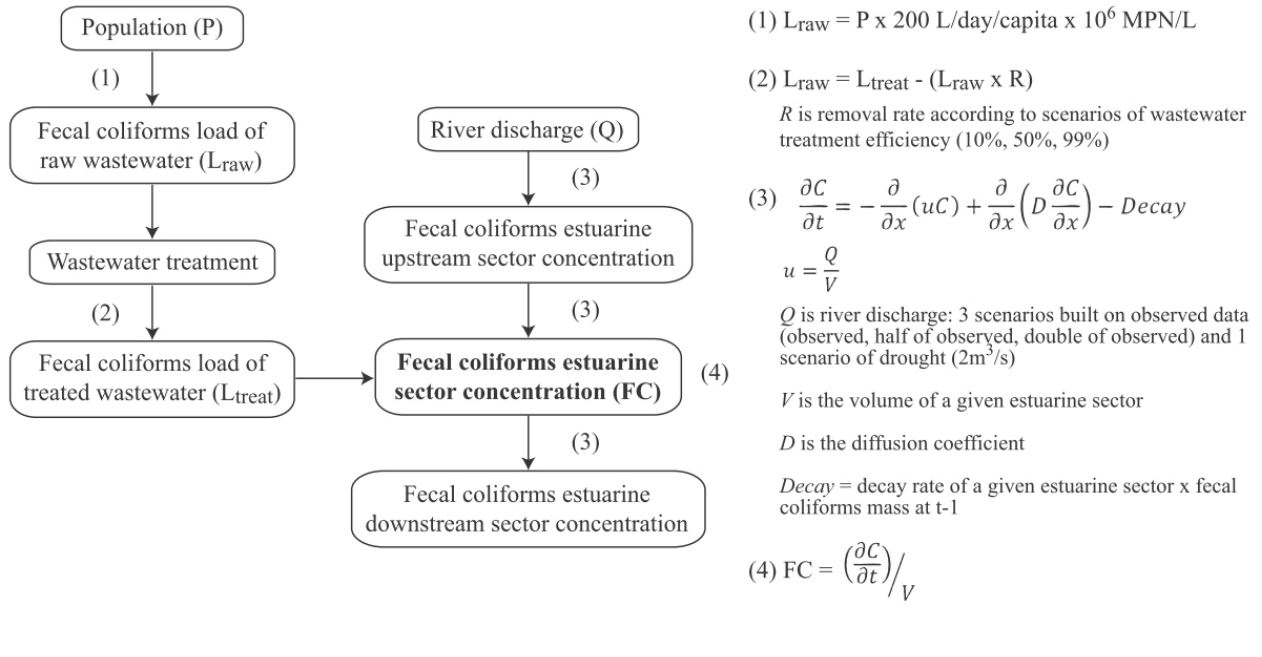
Fig. 4 . Chain of equations that link environmental component variables in the simulation model. Equation 4 calculates the rate of change of fecal coliforms concentration (FC) in a given estuarine sector. FC depends on: (i) the wastewater coliform load into that sector, dependent on population (P) and the level of fecal coliform removal rate (R), (ii) the transport across the estuarine sector, from upstream to downstream, (iii) bacterial decay.